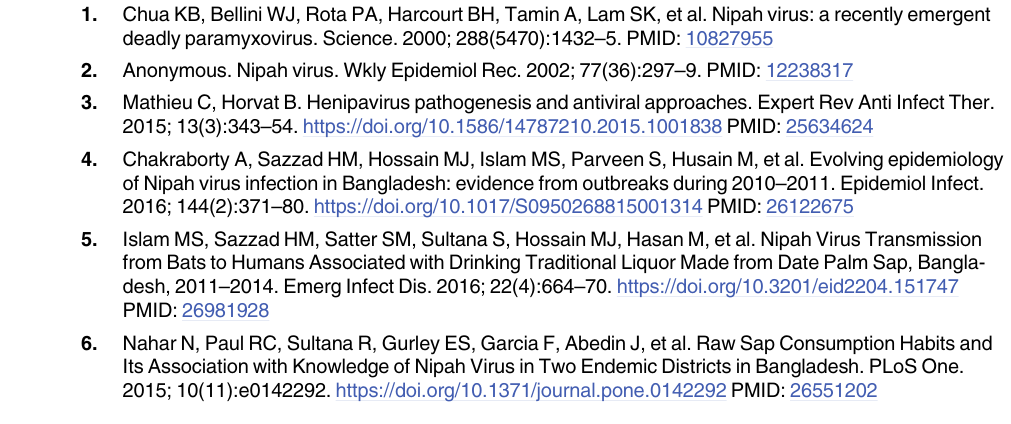
S7 Fig. Tissue cytokine response, panel II. Selected cytokine responses in tissues collected from animals inoculated by the intratracheal (A) or aerosol (B) exposure routes.